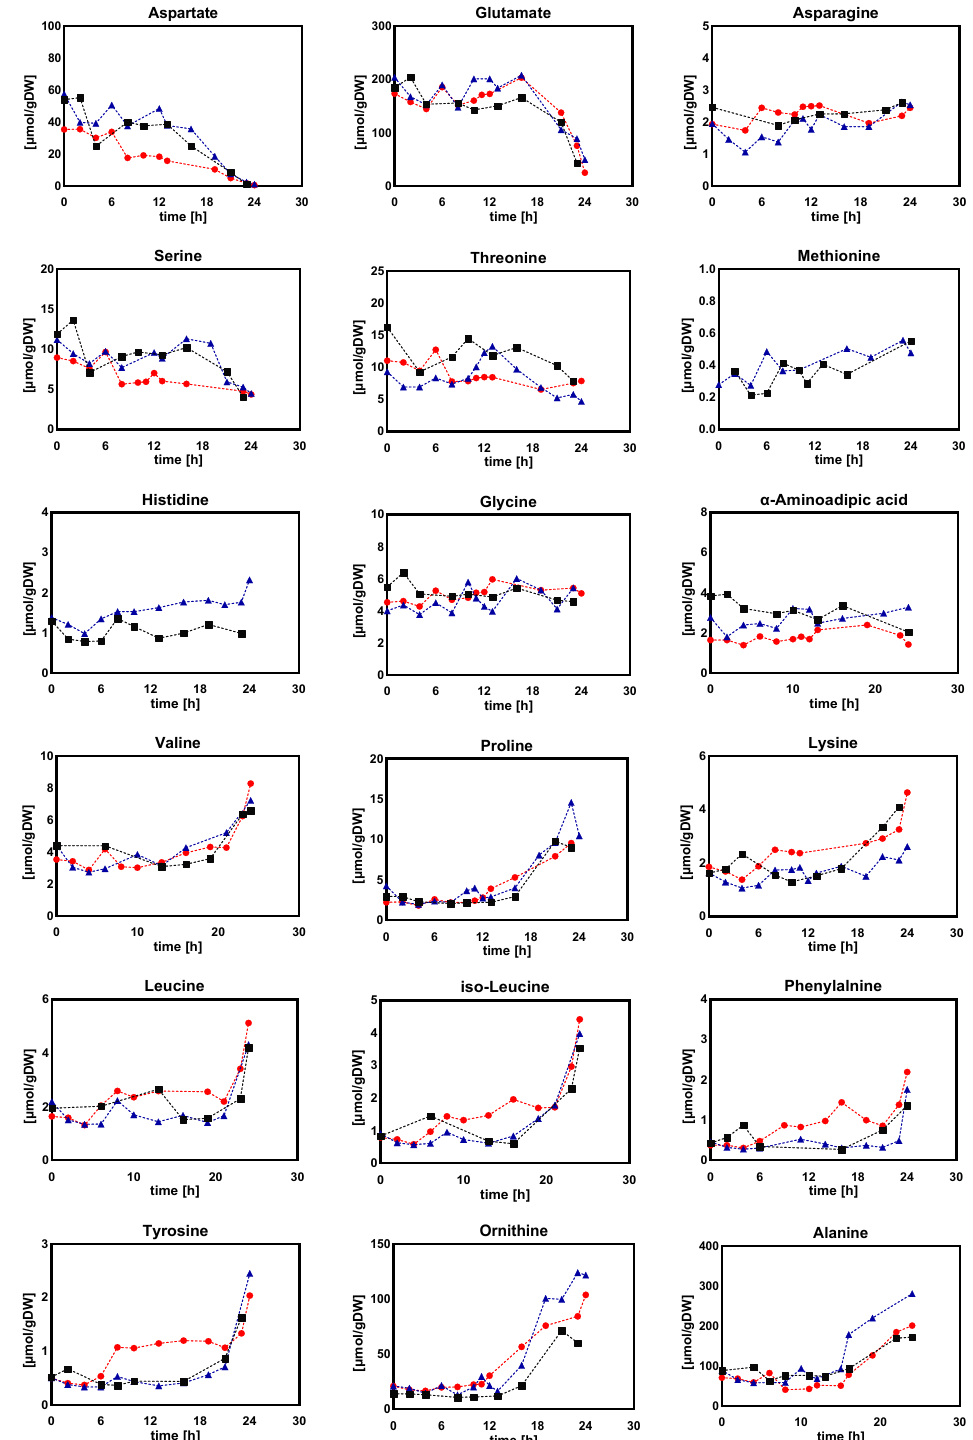
Figure 12. Intracellular amounts of amino acid in Penicillium chrysogenum Wisconsin 54-1255 under DO ramp-down experiments. The dissolved oxygen was linearly decreased from 60% to 0% in 24 h. Time 0 represents the start of DO ramp-down. Three legends represent three replicate